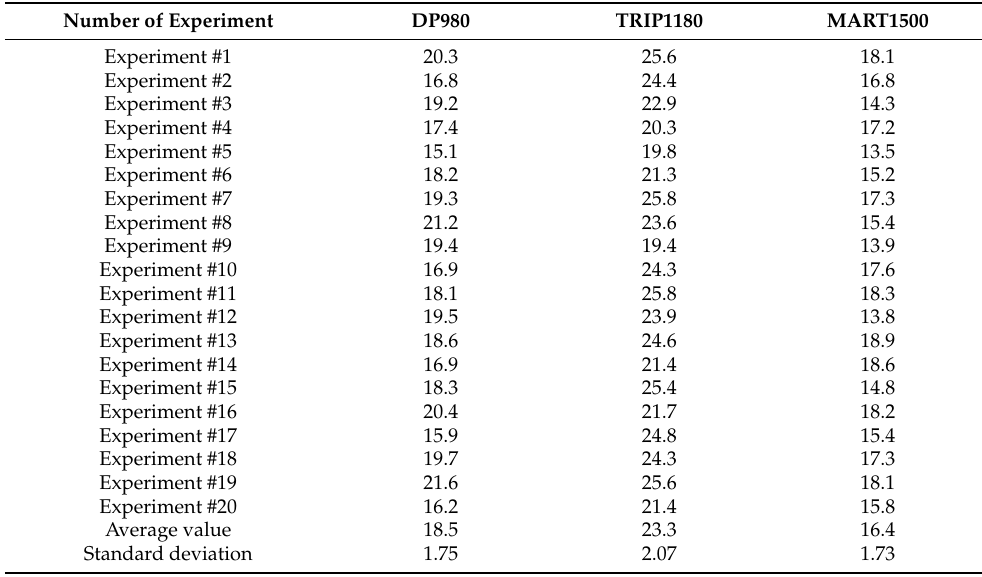
Table 3. Measured HER by manual